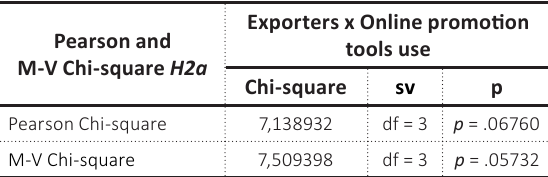
Table 4. Exporters and Online promotion tools